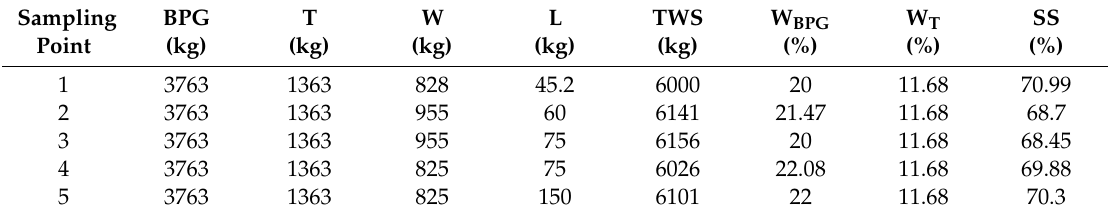
Table 1. Monitoring results of tailings-hemihydrate phosphogypsum filling slurry preparation 1 . Sampling